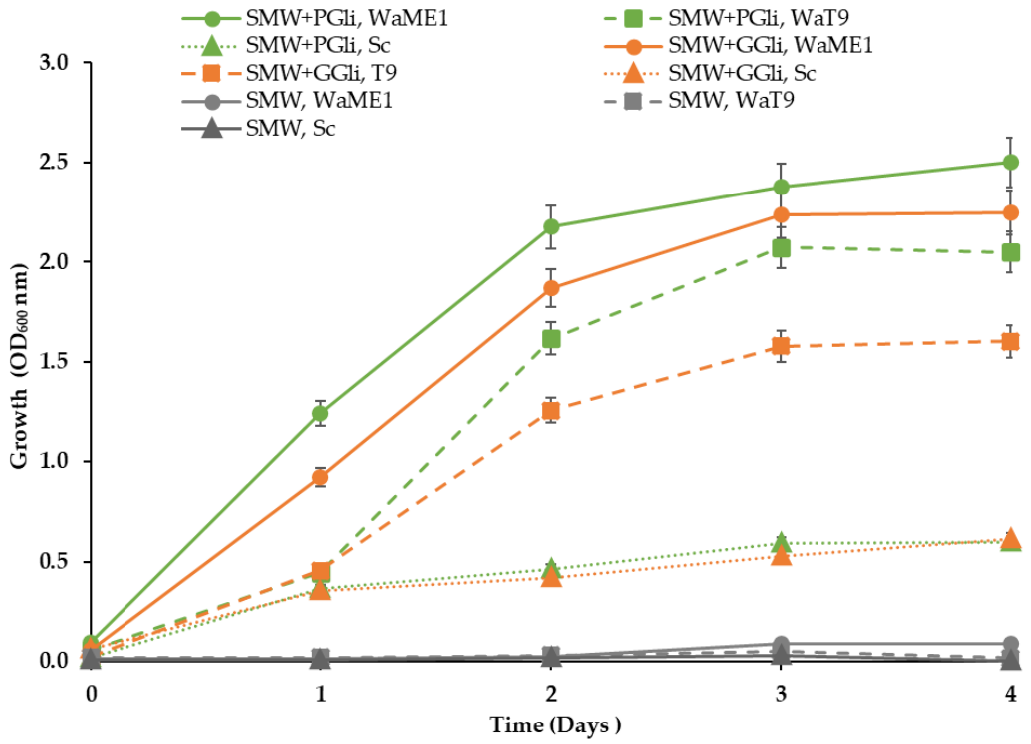
Figure 3. Ability to use gliadin proteins among W. anomalus strains. The growth of the W. anomalus strains ME1 (WaME1, solid line with circles) and T9 (WaT9, dashed line with squares) and the baker ´ s yeast (Sc, dotted line with triangles) in the media with gliadin proteins (SMW + PGli, green or SMW + GGli, orange) and without gliadins (SMW, grey) was monitored for 4 days. The points represent the average OD 600 ± standard deviation of three independent experiments.